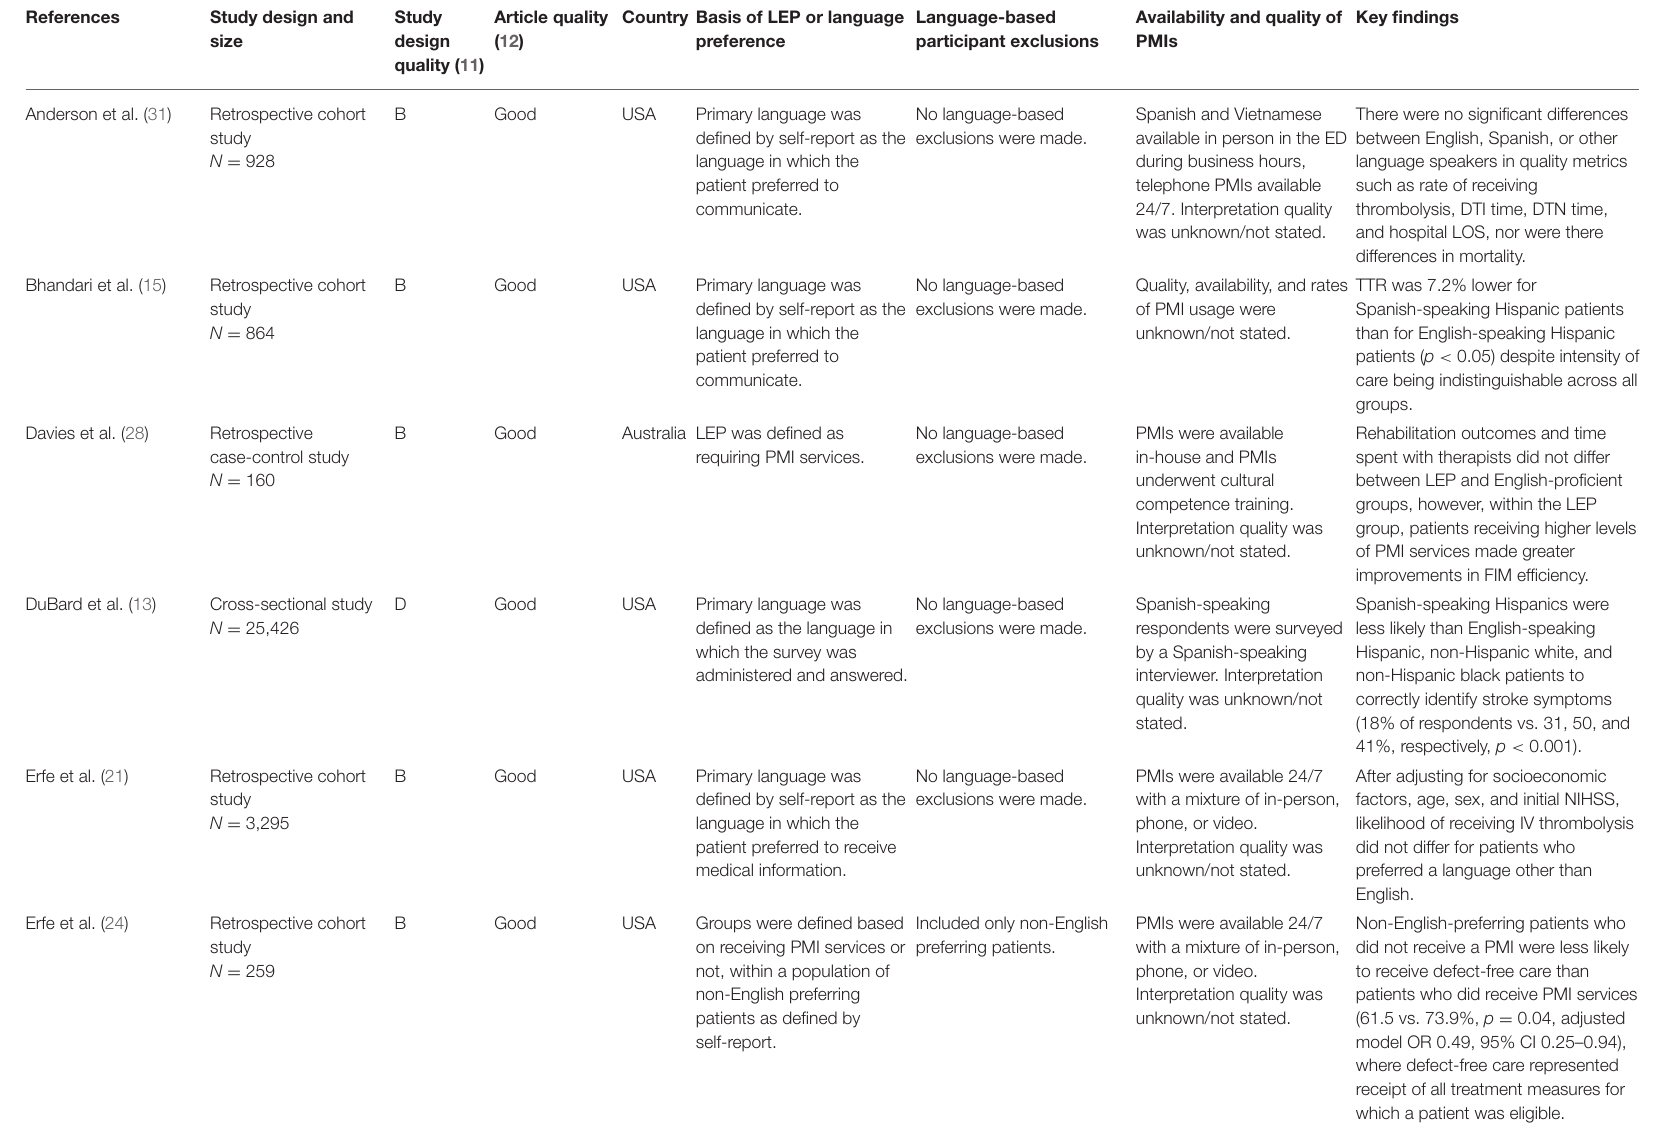
TABLE 2 | Studies included in the systematic